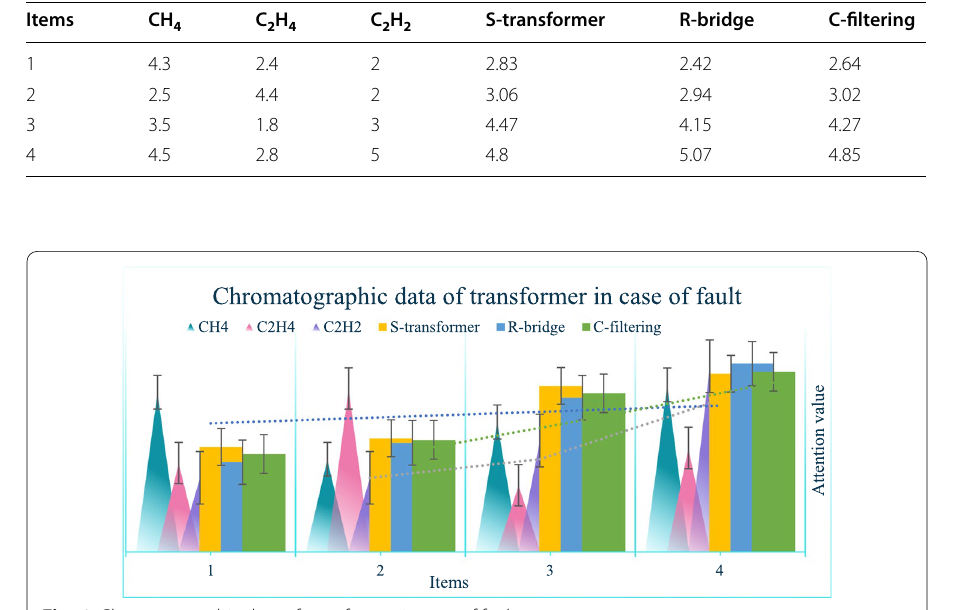
Fig. 6 Chromatographic data of transformer in case of